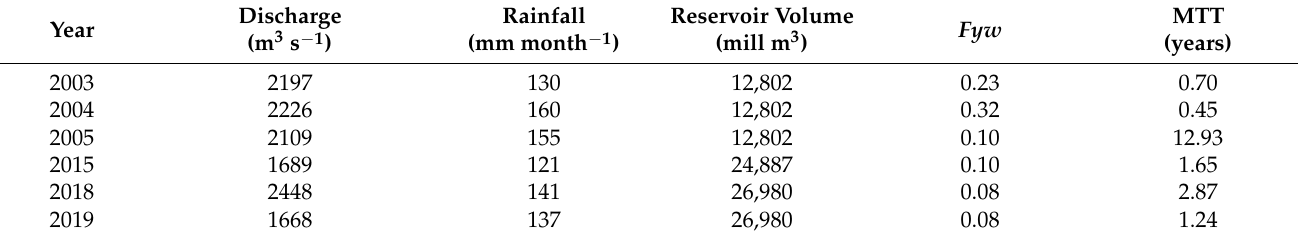
Table A1. Annual precipitation, monthly mean discharge, reservoir volume, Fyw , and MTT over the monitoring